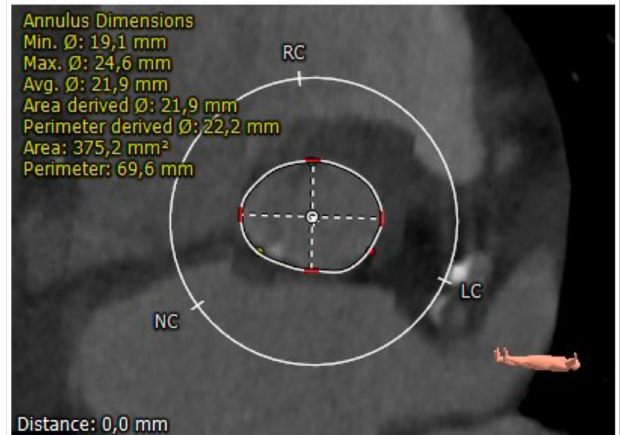
Figure 3. CT measurements of perimeter and area of aortic annulus.